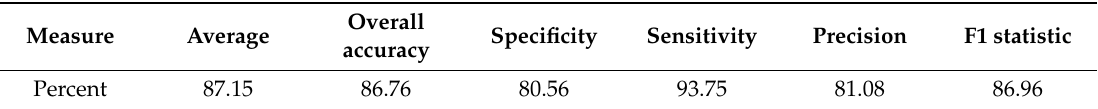
Table 2. Classification correctness of test samples for the TreeNet analysis to discriminate the insect-infested from the non-insect-infested forests in NE Iran.